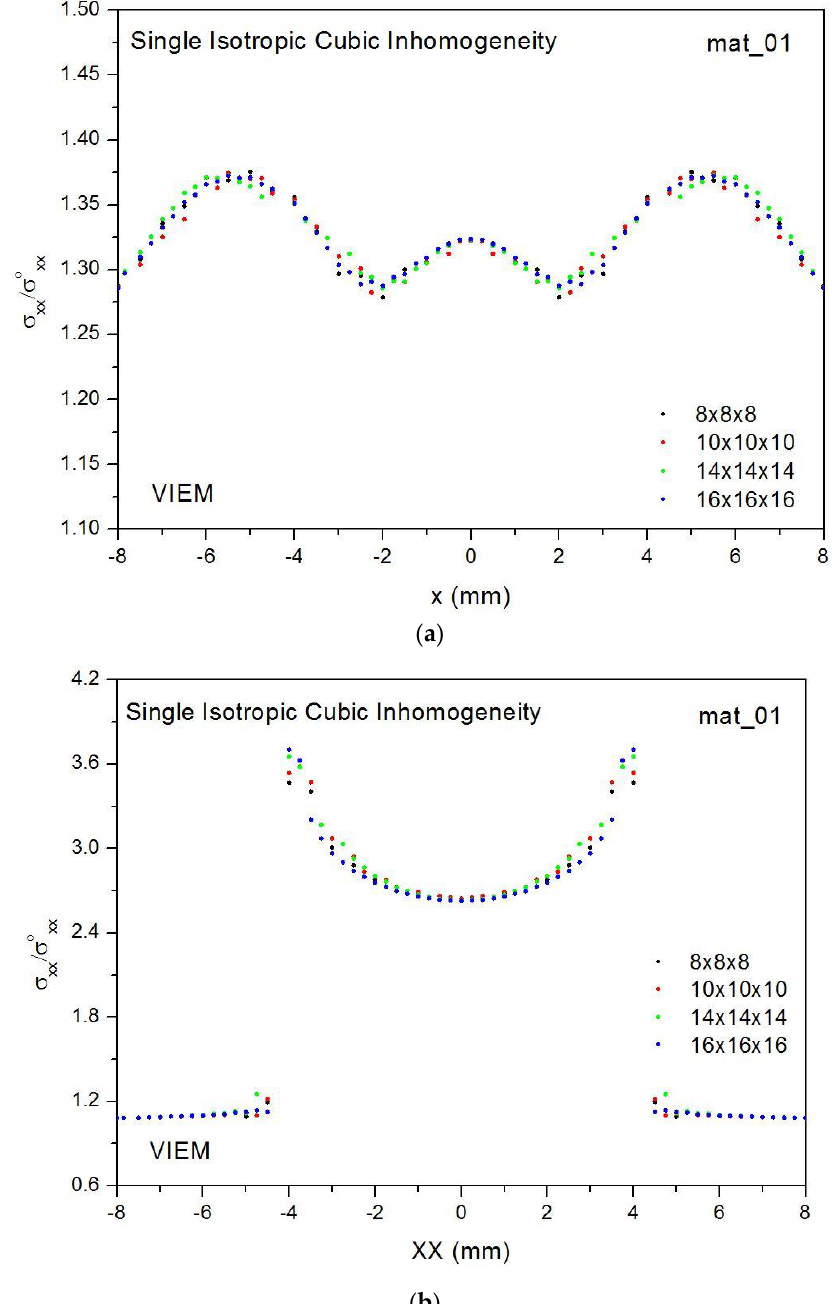
Figure 9. Numerical results using the volume integral equation method (VIEM) for the normalized tensile stress component (σ xx /σ oxx ) along the x -axis and the XX-axis (−8 mm ≤ x, XX ≤ 8 mm) for Model_8 × 8 × 8, Model_10 × 10 × 10, Model_14 × 14 × 14 and Model_16 × 16 × 16 under uniform remote tensile loading. ( a ) x-axis; ( b ) XX-axis.